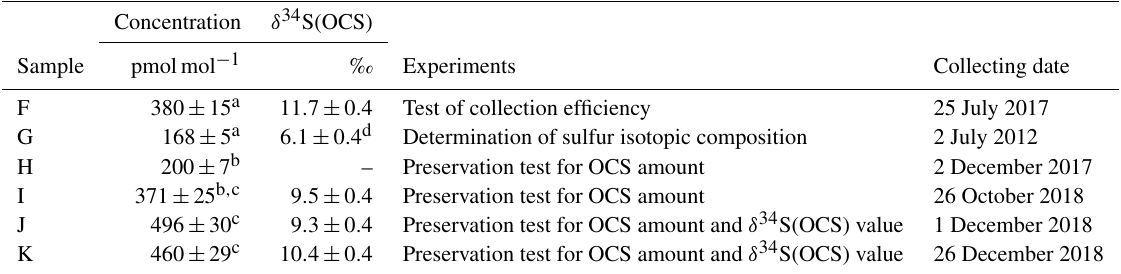
a Measured using a Q-MS with a picomole-level calibration curve. b Measured using a Q-MS with a nanomole-level calibration curve after sampling. c Measured using an IR-MS with a calibration curve in Fig. 4 after sampling with 1 σ uncertainty of 6%. d The previous δ 34 S(OCS) value measured by Hattori et al. (2015) was ( 4 . 9 ± 0 . 3 )‰.